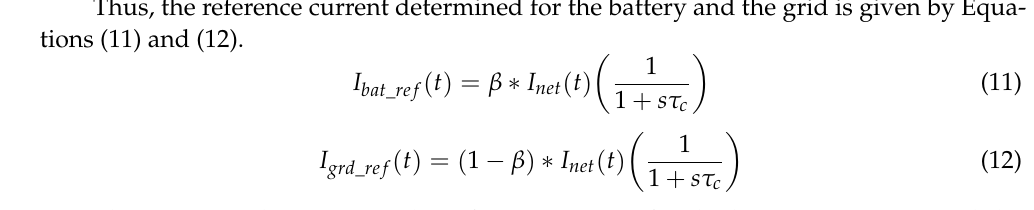
Figure 2. Variation of distribution factor with SOC.